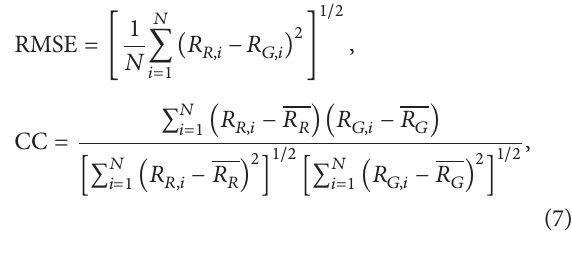
3.1.1. The Characteristics of 𝑍 , 𝑍 𝐷𝑅 , and 𝐾 𝐷𝑃 with Different Drop Shapes. The histograms of occurrence frequency for polarimetric variables, 𝑍 , 𝑍 DR , and 𝐾 DP , calculated by DSDs data for 4 years in Busan with different raindrop axis ratio relations, DS1, DS3, and DS6, were shown in Figure 5. The averages and modes of 𝑍 were around 26.2 dBZ and 32 ∼ 33 dBZ for all raindrop axis assumptions (Figures 5(a) ∼ 5(c)). It means that the reflectivity is not sensitive to the drop axis relation. In case of 𝑍 DR , there were two modes of occur- rence for all cases. The averages and standard deviation of each relation were 0.63 dB and 0.91 dB for DS1, 0.61 dB and 0.8 dB for DS3, and 0.66 dB and 0.82 dB for DS6. The low